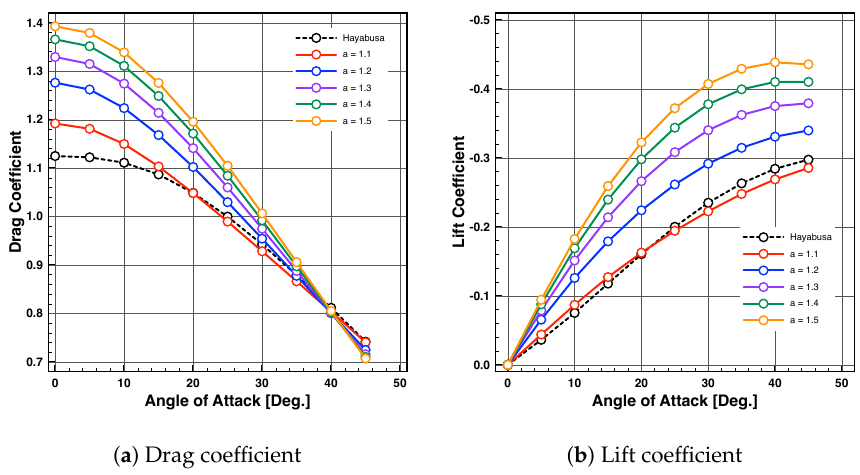
Figure 9. Comparison of the drag and lift coefficients for hyperbolic contours.